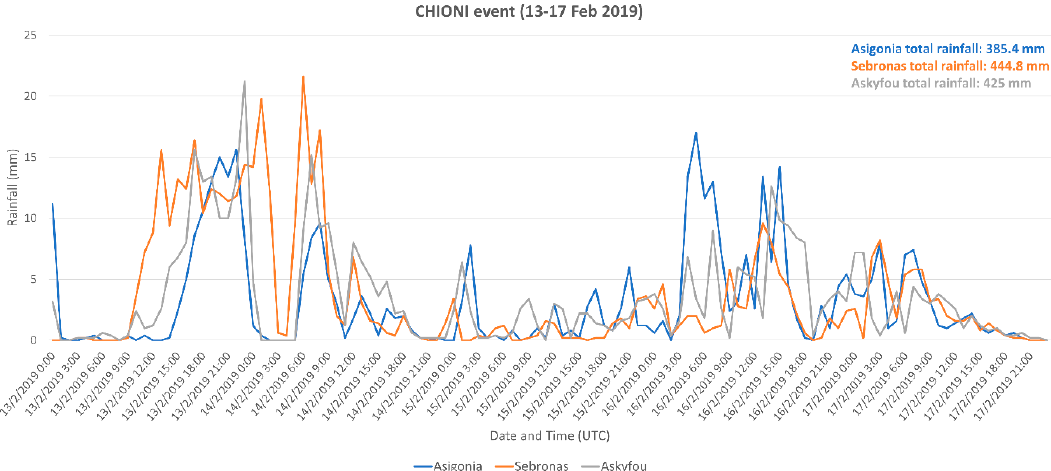
Figure 5. Time evolution of the observed 1-h accumulated rainfall during the 5-day period, starting at 0000 UTC 13 February 2019. Data are shown for 3 automatic stations located at mid-level altitude in the western part of the island (Asigonia (AG), Sebronas (SB), and Askyfou (AS)). The total amount of rainfall recorded during the event is shown in the upper right corner.